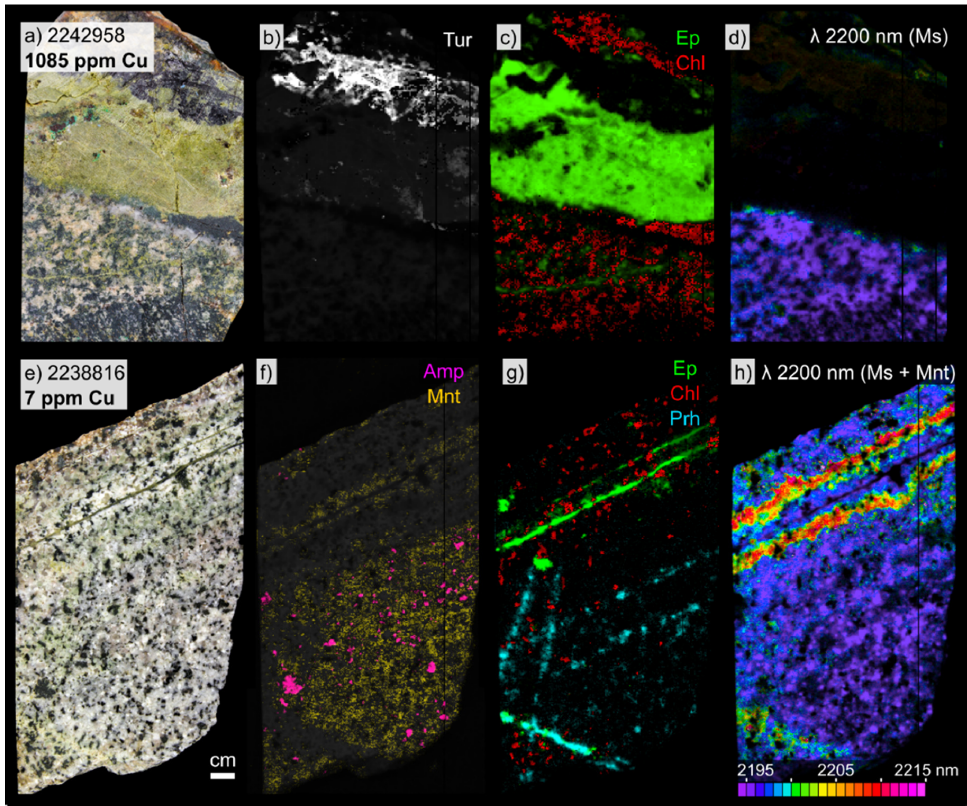
Figure 6. Photographs and processed hyperspectral imagery of samples from the Bethsaida deposit. Top: Sample 2242958, a mineralized sample from the Guichon facies; ( a ) color photograph; ( b ) distribution of tourmaline; ( c ) distribution of epidote (green) and chlorite (red), and ( d ) position of the 2200 nm absorption. Bottom: Sample 2238816, an unmineralized sample from 6 km away from the open pit, with 7 ppm Cu; ( e ) color photograph; ( f ) distribution of montmorillonite (yellow); ( g ) distribution of chlorite (red), epidote (green), prehnite (blue), and amphibole (purple), and ( h ) the absorption position of the 2200 nm Al 2 -OH feature for white mica, the mixture of white mica and